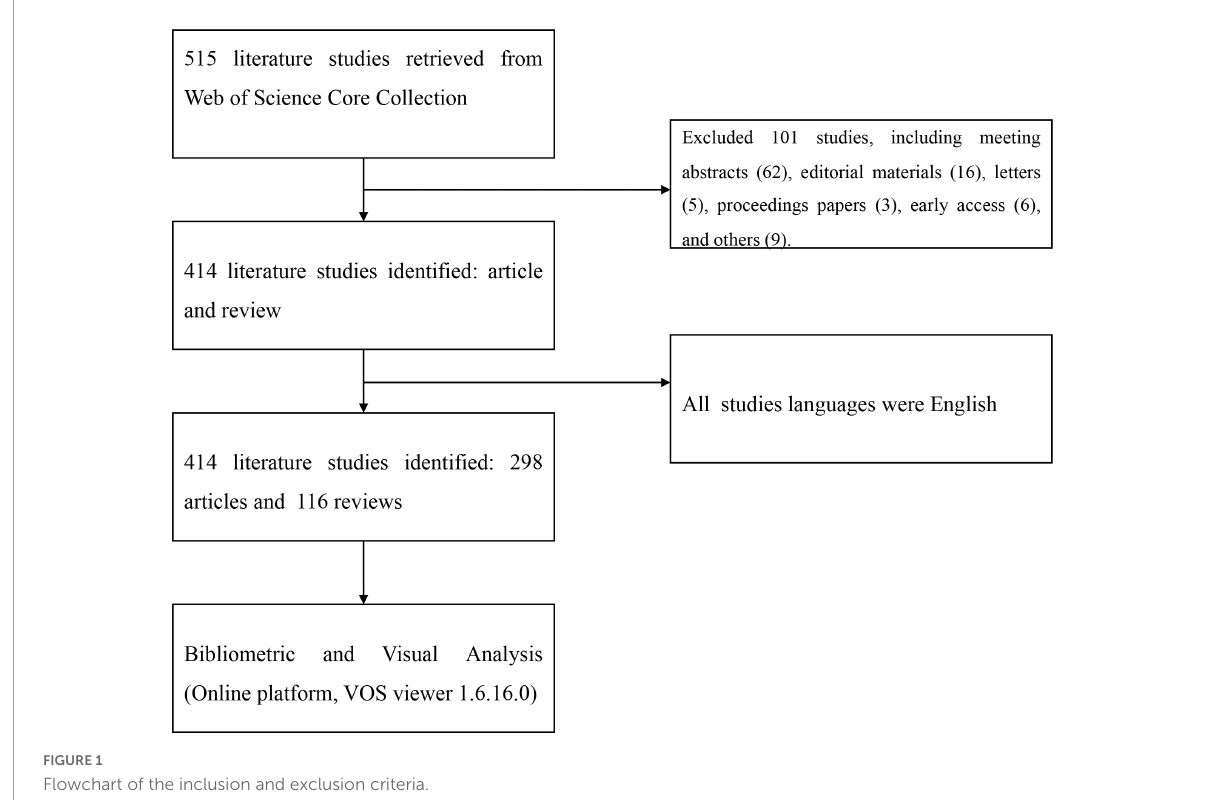
FIGURE1 Flowchart of the inclusion and exclusion criteria.